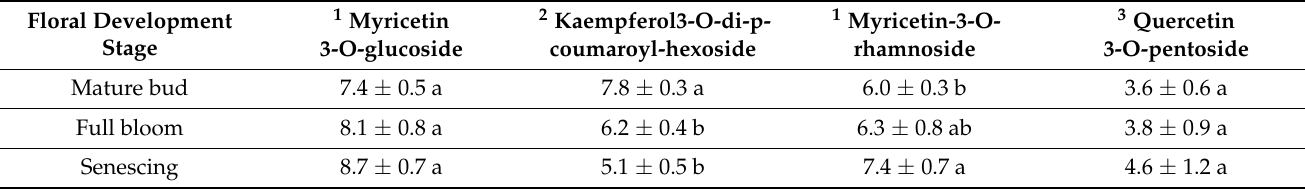
Table 3. Content of flavonoid compounds, in the three flowering stages of P. ‘Endsleigh’, expressed as mg/g of dry weight. Floral